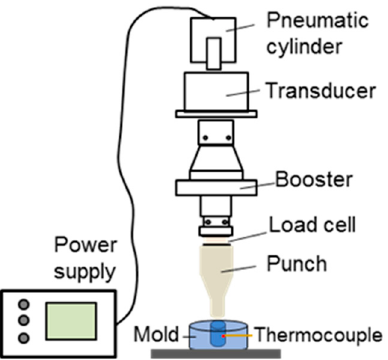
Figure 1. Schematic diagram of the ultrasonic assisted sintering (UAS) apparatus.